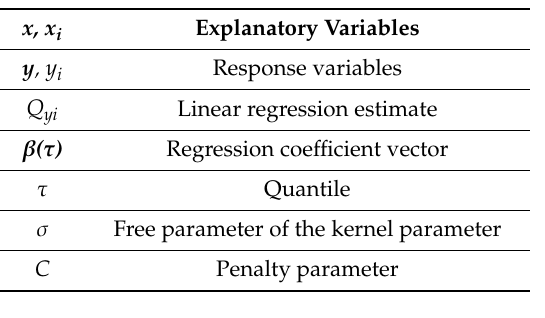
Table 1. Parameter